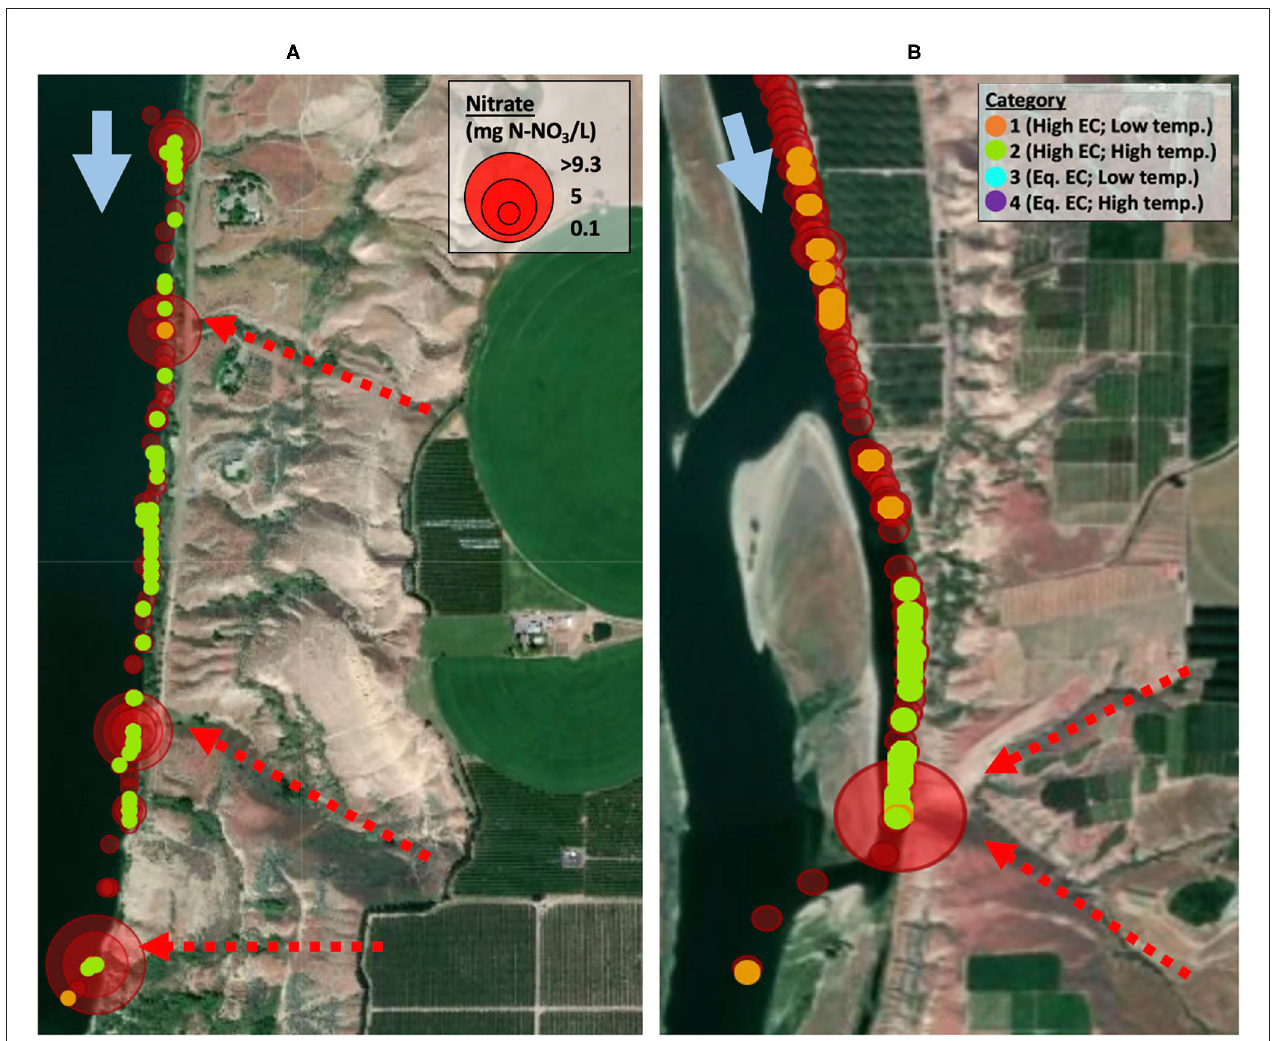
FIGURE 11 | (A) Riverbed anomalies and (B) nitrate concentrations along the shoreline adjacent to the 300-Area of the Hanford Reserve. This shoreline is dominated by anomalies with high EC. The river water along the shoreline also has high nitrate concentrations. Map data from Google,